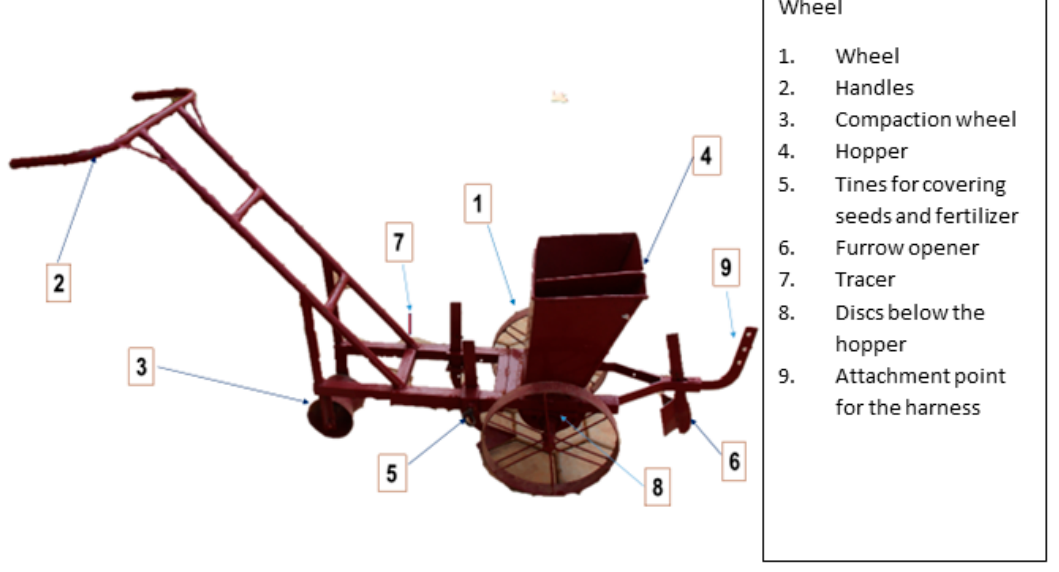
Figure 1. The Gangaria planter with two hoppers: one for seeds and the other for compost/soil amendments.